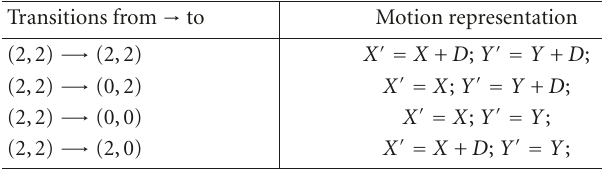
Table 3: Possible motion representation of state (2,0) given by state-transitions of the SIMM model. Transitions from → to Motion